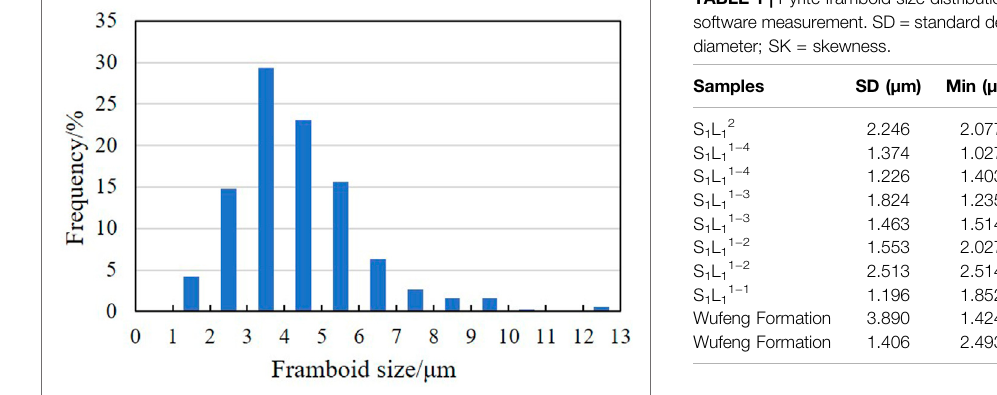
FIGURE 4 | Pyrite framboid size distribution histogram.